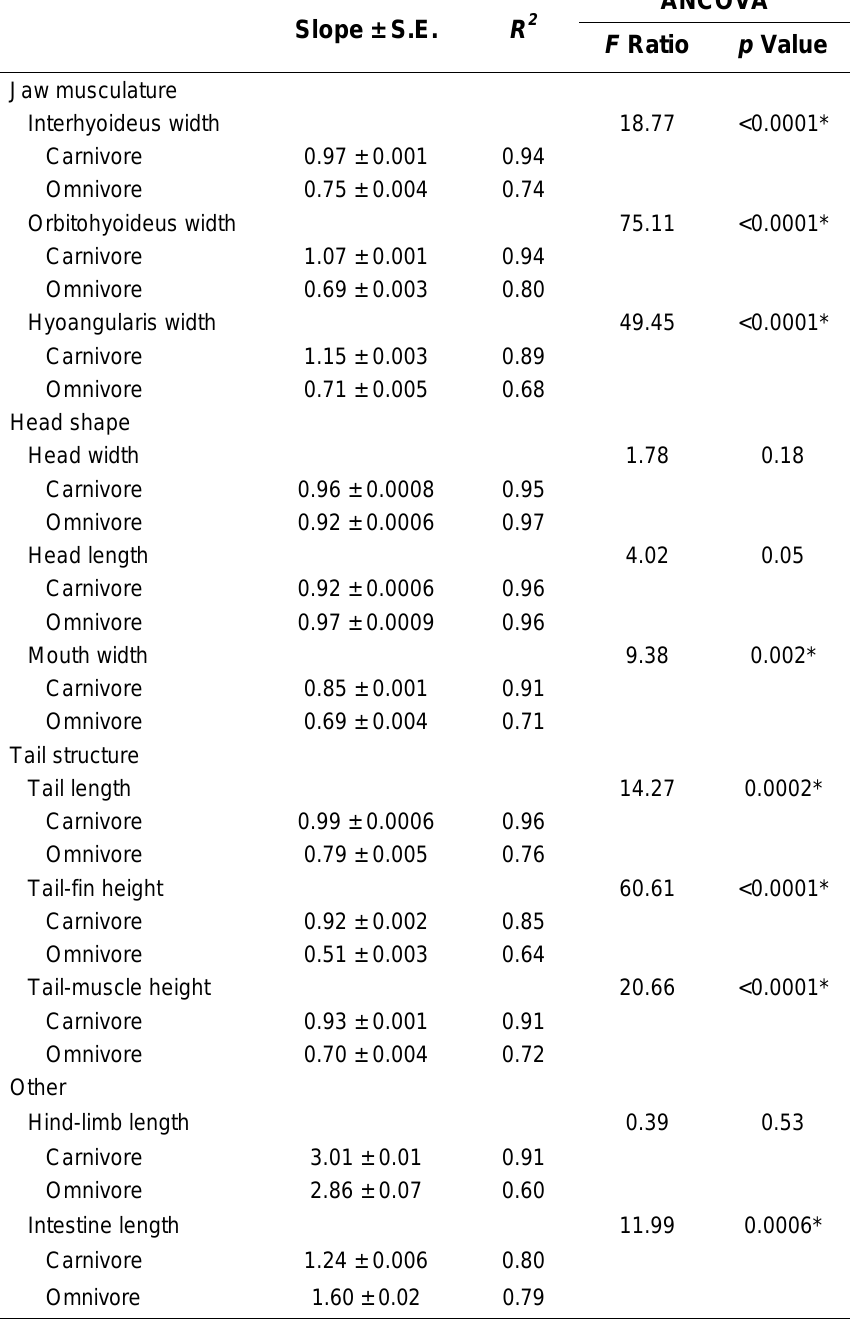
Linear Regressions of Log-Transformed Traits on Log SVL and Results of ANCOVA Comparing Slopes of Traits Plotted Against SVL in the Carnivore and Omnivore Phenotypes of Spadefoot